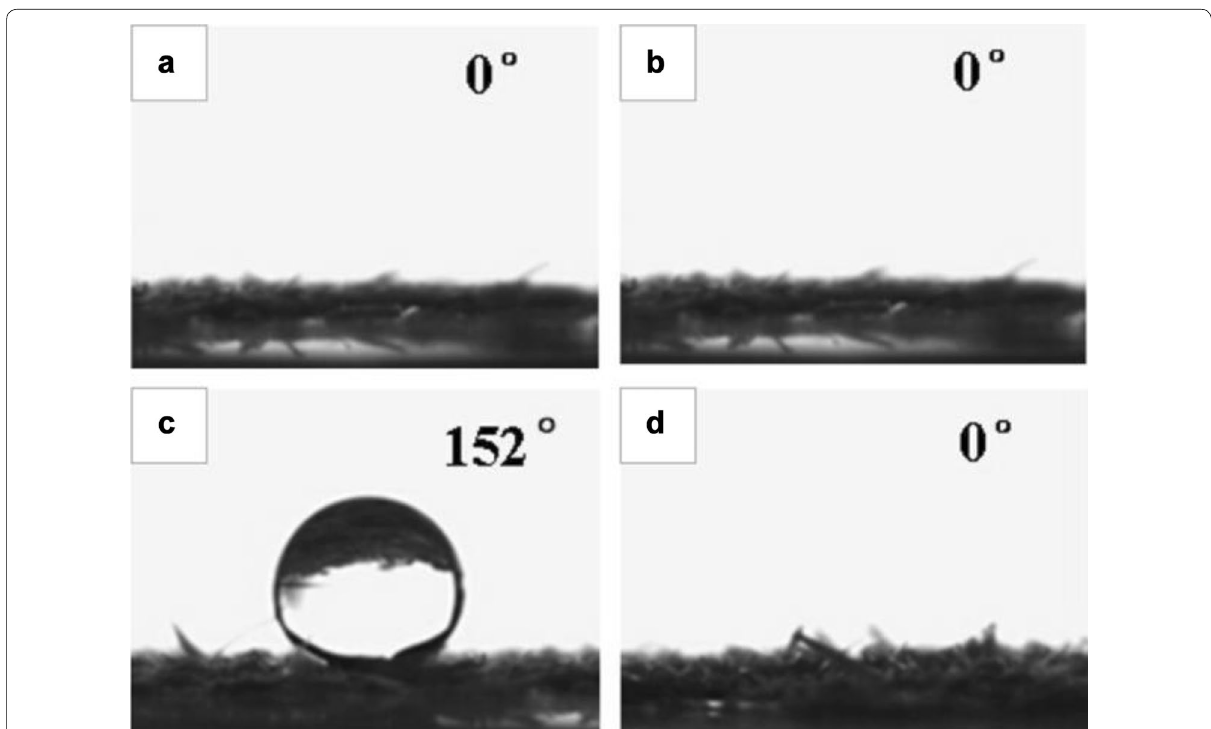
Fig. 3 Images of a water droplet ( a ) and an oil droplet on raw corn straw fiber ( b ); a water droplet ( c ) and an oil droplet ( d ) on prepared superhy‑ drophobic/superoleophilic corn straw fiber. Compared to raw corn straw fiber, the resulting corn straw fiber indicates its superior superhydropho‑